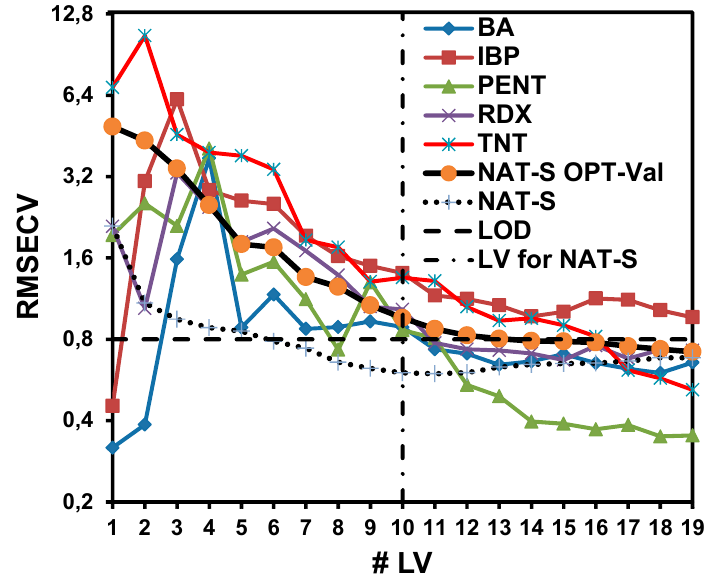
Figure 5. Dependence of the root-mean-square error of cross-validation (RMSECV) on LV for the considered interferences: the NAT-S optimization of the validation set (OPT-Val) and NAT-S models.